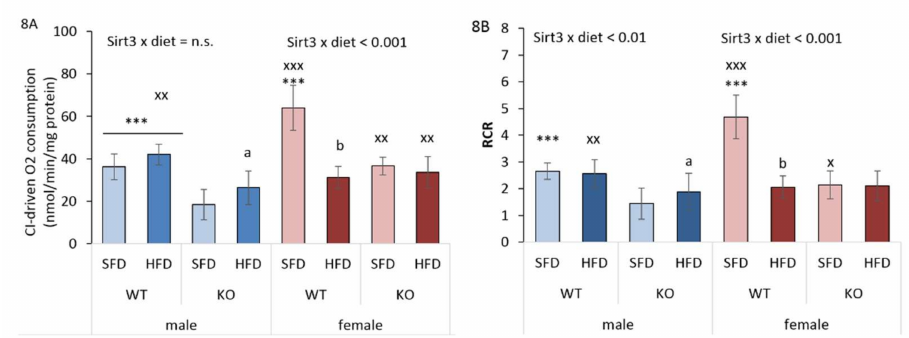
Figure 8. Complex I (CI)-driven respiration and the respiratory control ratio (RCR) of liver mitochondria of Sirt3 wild-type (WT) and knockout (KO) mice of both sexes fed with a standard fat diet (SFD) or a high fat diet (HFD) for 10 weeks. ( A ) CI-driven respiration. Males: HFD-fed vs. SFD-fed KO mice ( a p < 0.05); WT vs. KO mice (*** p < 0.001). Females: HFD-fed vs. SFD-fed WT mice ( b p <